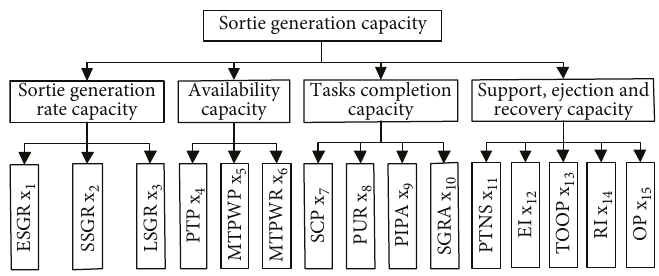
Figure 1: Index system for sortie generation of carrier